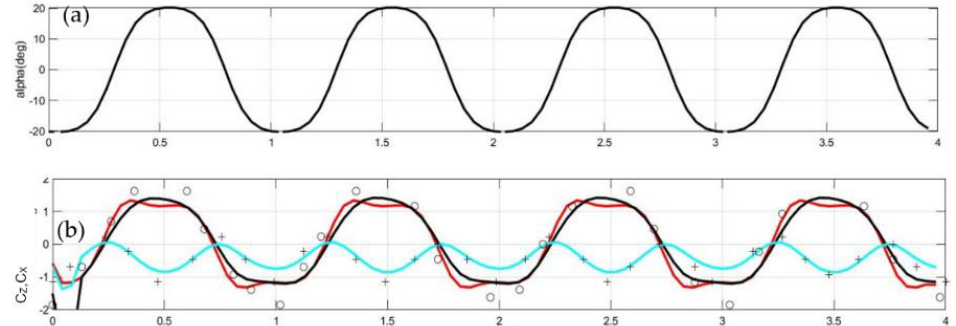
Figure 2. Flapping thruster performance as obtained from the unsteady hydrofoil theory and a comparison with experimental data by [26], in the case of foil of c = 0.1m, AR = 6, for U = 0.4m/s, Str = 2 fh 0 / U = 0.23, h 0 / c chord = 0.75, and θ 0 = 23 ◦ . Time history of the ( a ) dynamic angle of attack and ( b ) flapping thruster loads against non-dimensional time t/T , where T = 1/f : (cid:0) (cid:1) C Z = F Z / 0.5 ρ U 2 A shown by black and red lines and experimental data shown by using circles, (cid:0) (cid:1) and C X = F X / 0.5 ρ U 2 A shown using cyan lines and experimental data shown using crosses.